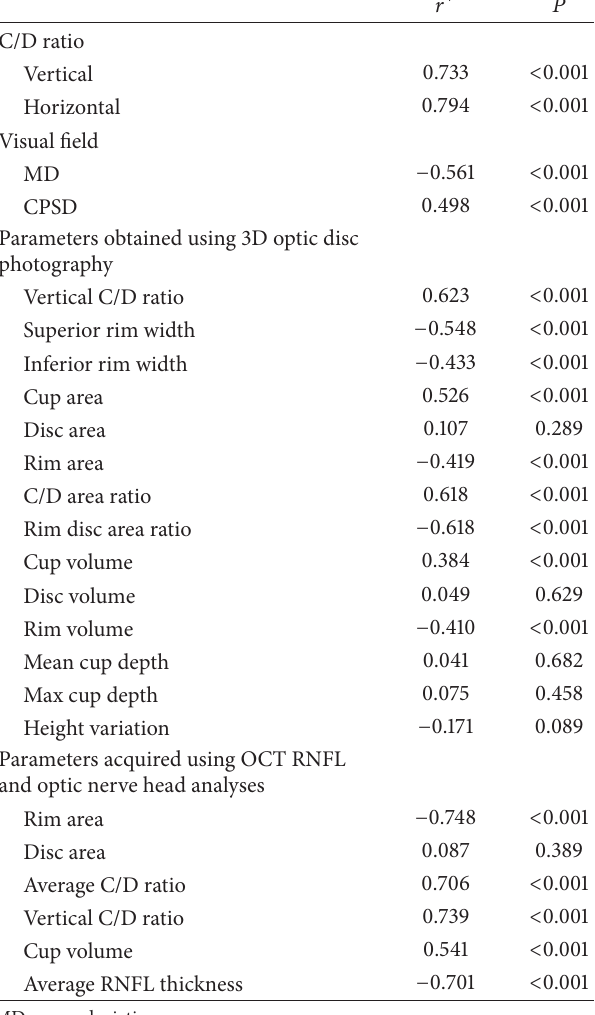
Table 3: Correlations between the DDLS and stereometric parame- ters obtained using 3D optic disc